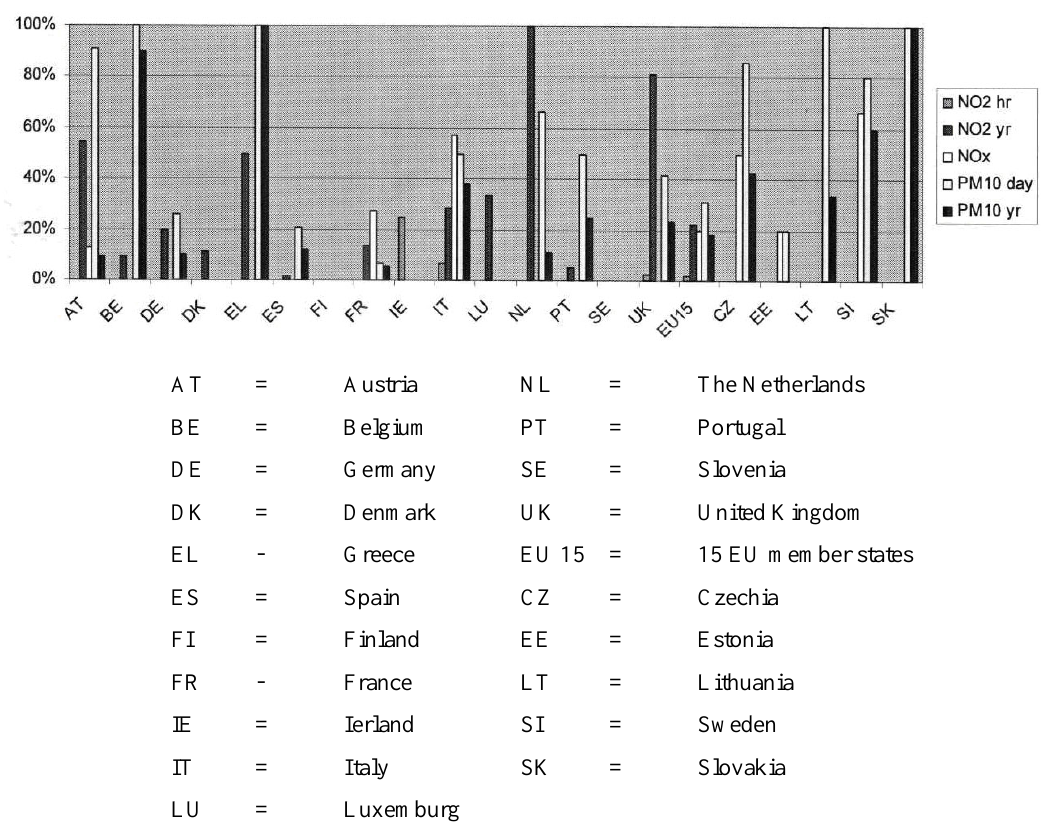
Figure 1. Percentage of zones exceeding the limit value (plus margin of tolerance if existing) for NO /NO and PM in 2003 2 x 10